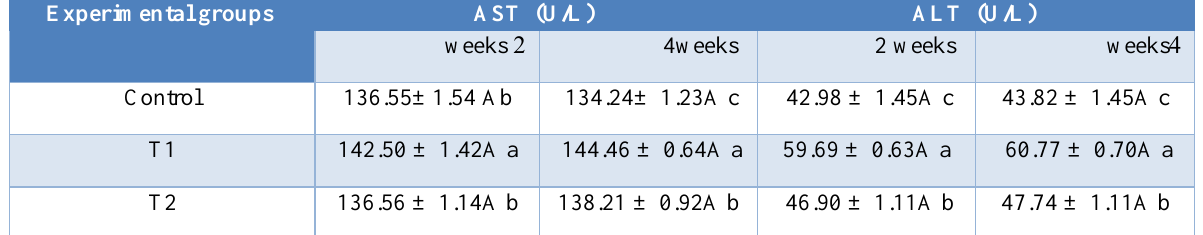
Table, 2: Serum aspartate amino transferase (AST) activity (U/L) and Serum alanin amino transferase (ALT ) activity (U/L) under effect of biogenic Se- Nanoparticles in compare with selenite solution during 2 and 4 weeks , Means ±SE. n- 6. Experimental groups